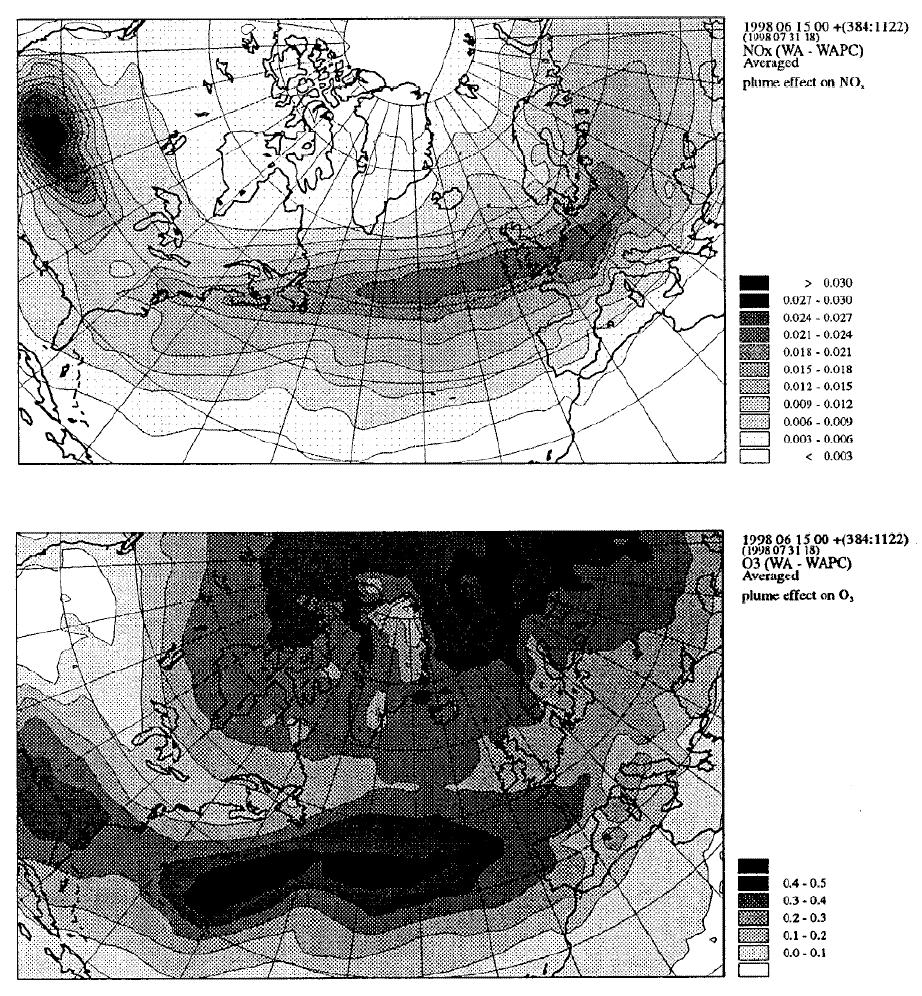
Fig. 20. Reduction in the aircraft contribution to NO x (top) and ozone (bottom) due to plume processes in the NAFC. All numbers are in ppb. The results shown are from level four, counting from the 100hPa model top, σ -coordinates are used and the height of the level equals 215hPa when the ground pressure is 1000hPa. Reprintedfrom Kraabøl et al. (2000a). An edited version of this paper was published by AGU. Copyright (2000) American Geophysical